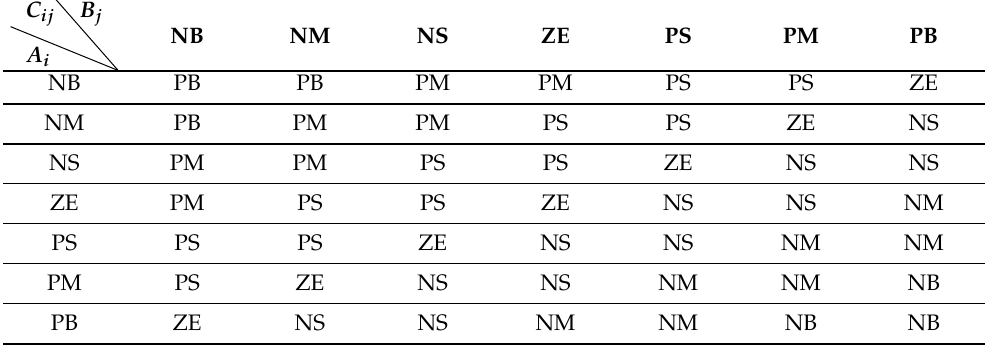
Table 1. Three-way fuzzy control rules.